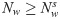
Successive stages of a friable floating fibrin structure formation.a—thrombus nucleation, b—formation of fibre-like fibrin structure, c—thick and friable floating fibrin structure. Shown are the color maps of N
w—the weight-average number of monomers in fibrin-polymer in the vessel, with red areas representing regions of fibrin gel formation (Nw≥Nws). Streamlines are plotted to visualize the flow, and the separatrix is shown with a dashed line. Parameters used in these simulations are: Re = 180, h = 0.6, d~=0.4, d~=12. Note that only a fragment of the vessel closest to the plaque is depicted.